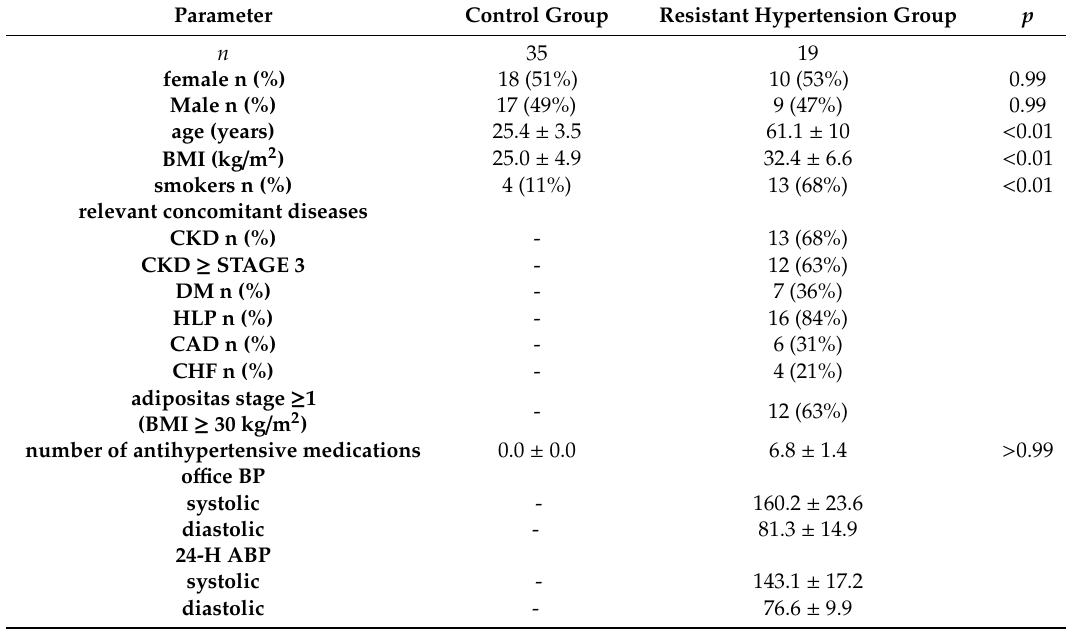
Table 1. Characteristics of the control and patient